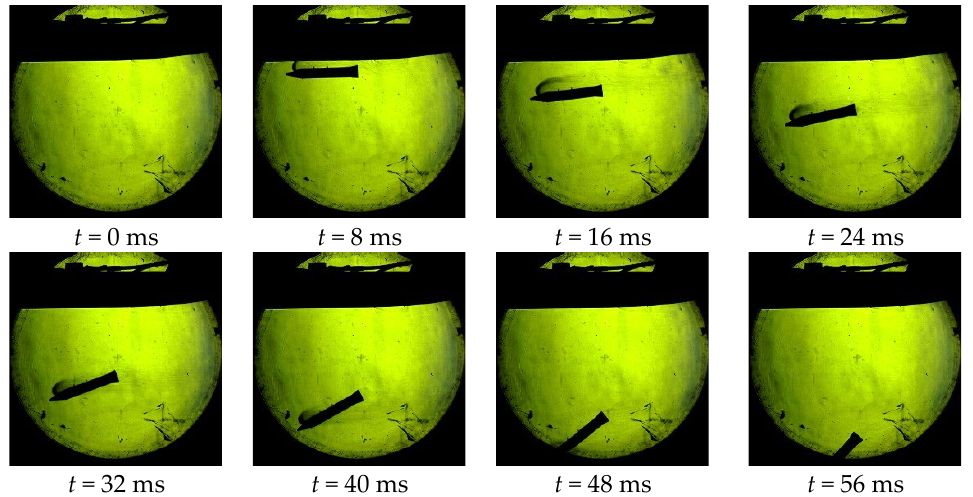
Figure 15. Test image of the revolution body’s angle of attack change with a jet at 4.0 MPa for M = 0.6.